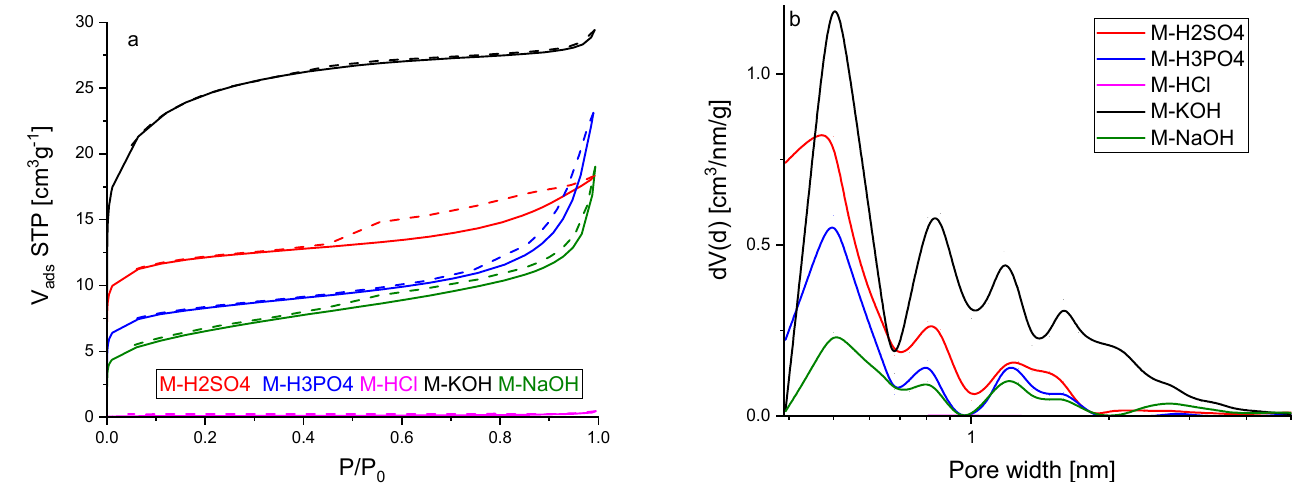
Figure 4. Adsorption–desorption isotherms of nitrogen ( a ) and micropore pore size distribution calculated by the DFT method ( b ) for activated carbons from molasses.